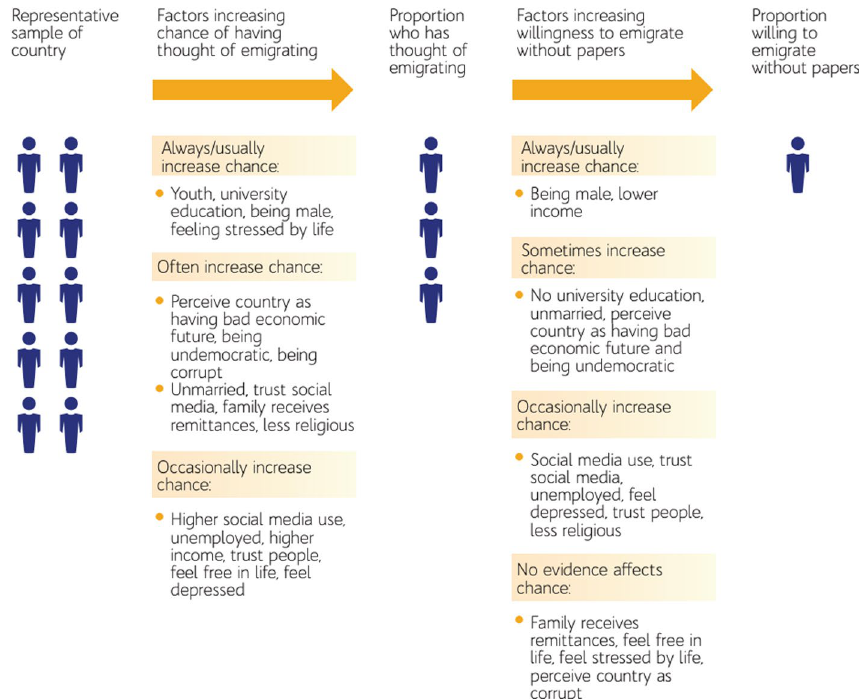
Fig. 4 Factors increasing chance of having thought of emigrating and factors increasing willingness to emigrate without papers, across the MENA